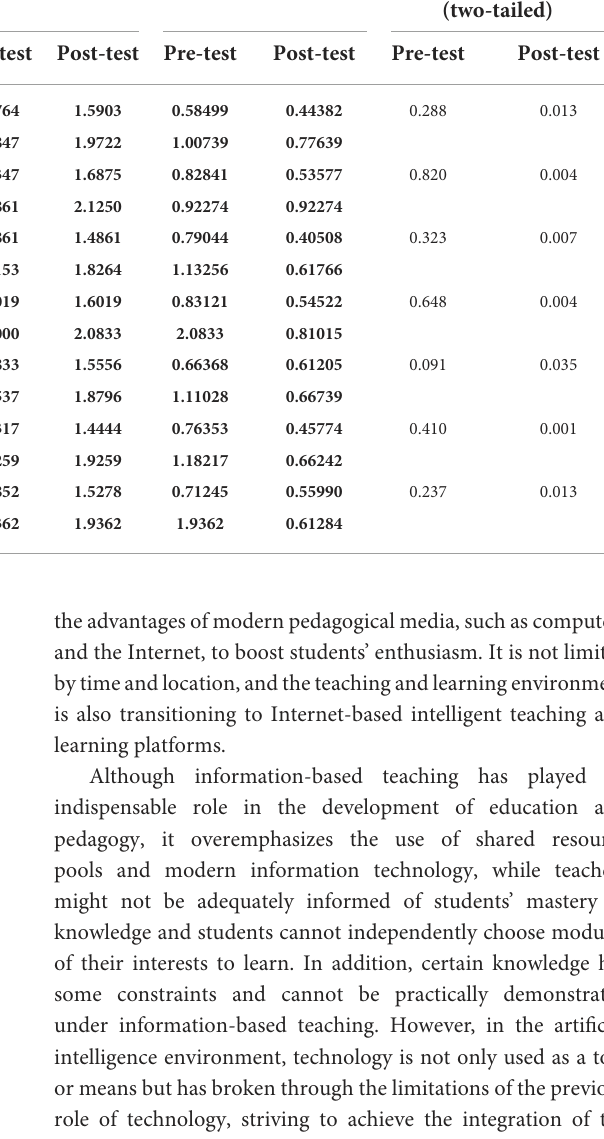
TABLE 3 The independent sample’s t -test of the pre-test and post-test for each dimension of the level in the two groups. Dimension